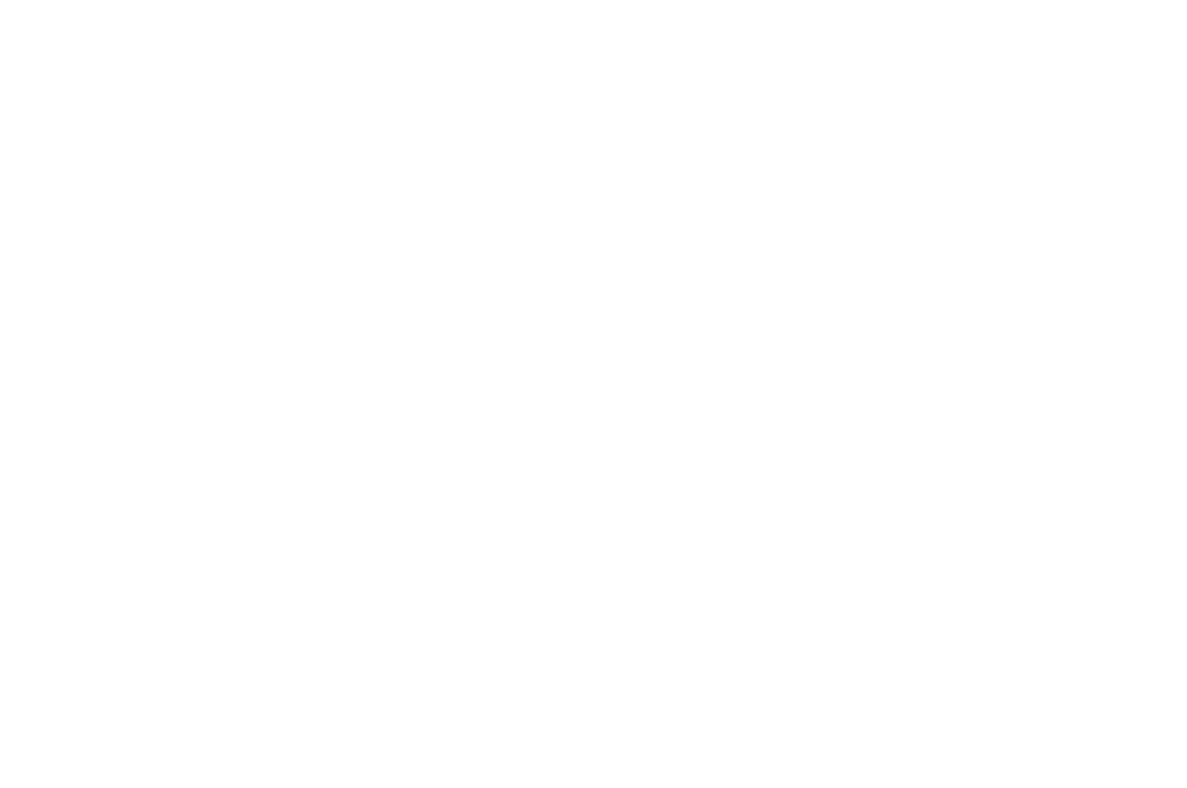
Figure 10. Comparison of four model evaluation